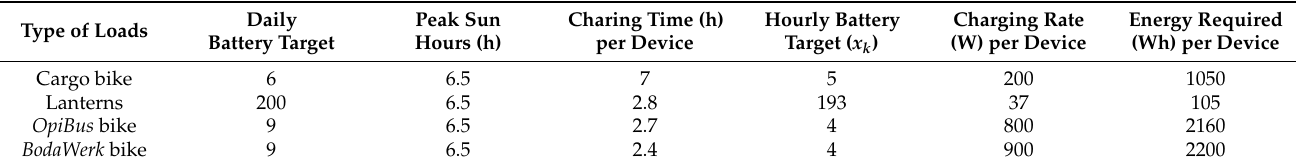
Table 6. Detailed information of the major loads at Mbita WeTu Hub